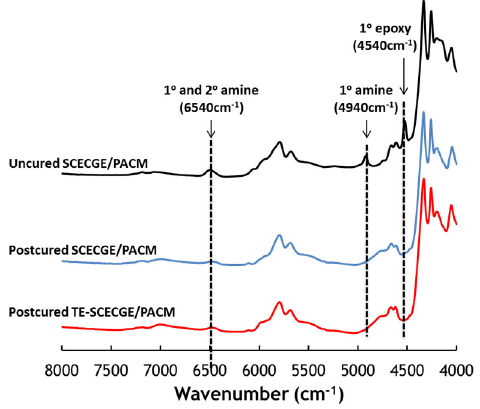
Figure 3. Extent of the epoxy / amine curing reaction via near-IR.